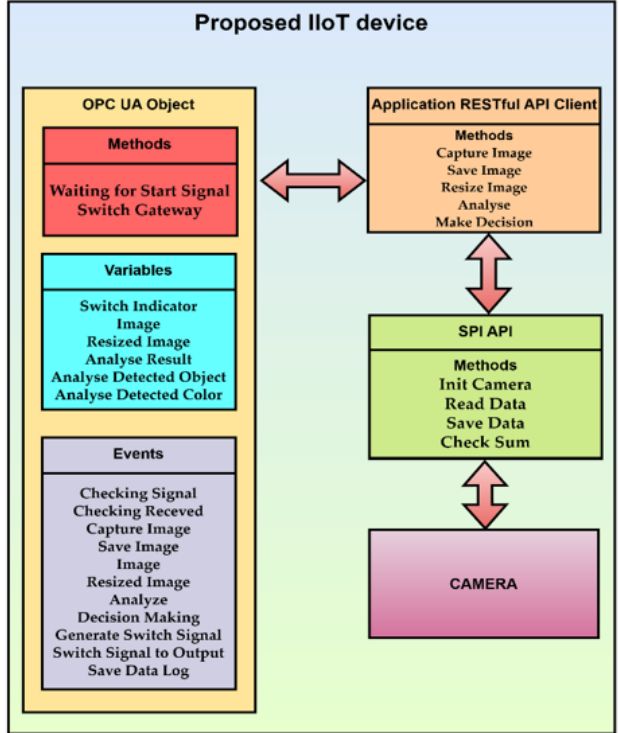
Figure 16. The block diagram of the proposed IIoT device.